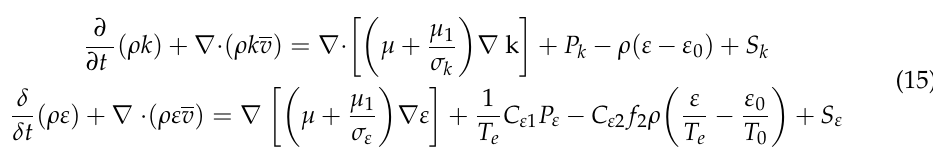
Figure 3. Boundary heat flux and temperature at 25 °C.